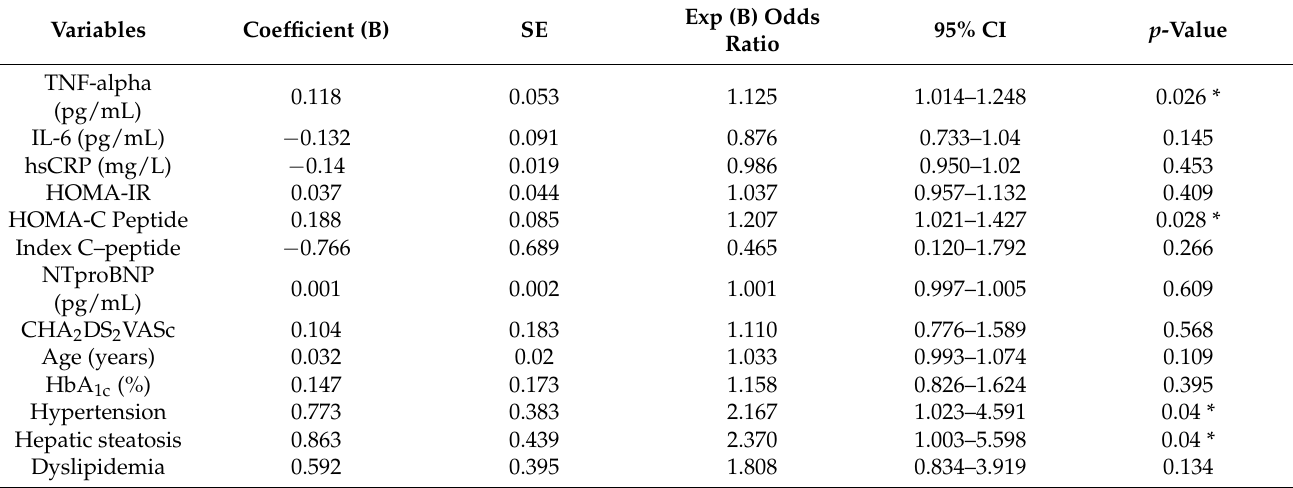
Table 6. Univariate analysis models for risk of